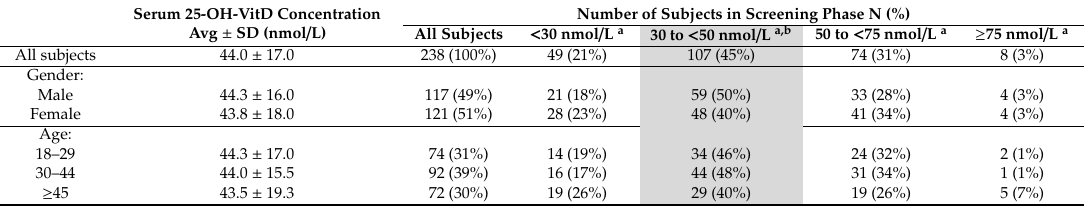
Table 1. Descriptive statistics for subjects included to screening (N =